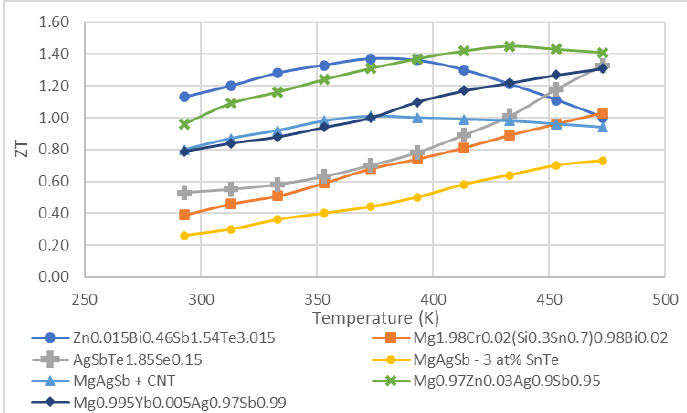
Figure 8. The thermoelectric performance of market standard thermoelectric materials over the high-temperature range: Mg 0.97 Zn 0.03 Ag 0.9 Sb 0.95 has an average ZT value of 1.28 across the 200 K low-Table 0. Bi 0.46 Sb 1.54 Te 3.015 gives an average ZT value across the temperature range of 1.23, peaking at a value of 1.37 at 373 K. By using a melt-spinning-based synthesis during the production of the material, nanostructuring could take place that allows zinc telluride nanoprecipitates to form within the material.